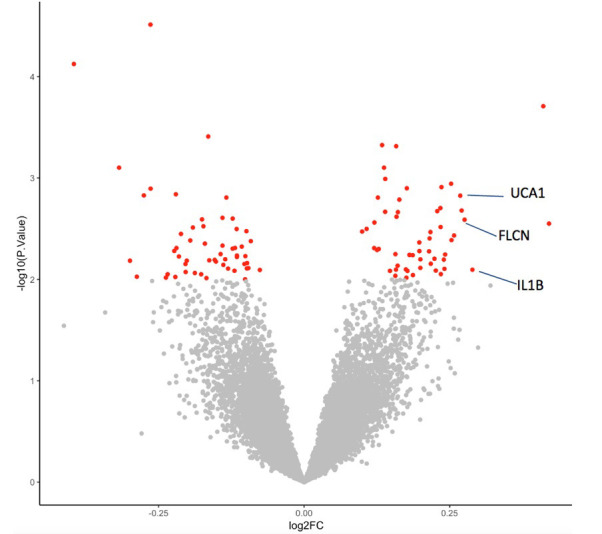
Differential transcriptional response to glucose among individuals with diabetes with and without retinopathy.Volcano plot summarizing genes exhibiting a differential response to glucose between individuals with diabetes with and without retinopathy (RGPDR–nDR). The difference in FC between groups is represented on the X-axis and p-value of this difference on the Y-axis. Red indicates the 103 genes showing the most differential expression between individuals with and without retinopathy (p<0.01). FC, fold change. Source and code files for this plot are available in Figure 2—source data 1 and Source code 5. An additional source file for this plot can be found in Gene Expression Omnibus (GEO) at https://www.ncbi.nlm.nih.gov/geo/ under accession code GSE146615.Figure 2—source data 1.Differential transcriptional response volcano plot.Figure 2—source data 2.Multidimensional scaling plot.Figure 2—source data 3.Multidimensional scaling plot.Figure 2—source data 4.Multidimensional scaling plot.Figure 2—source data 5.Multidimensional scaling plot.